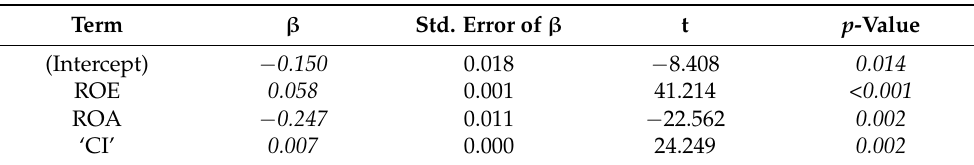
Table 8. The results of estimation of the regression for Model